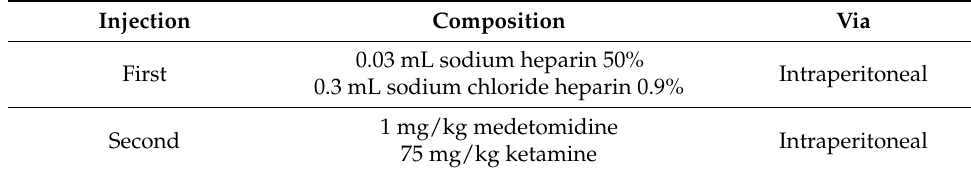
Table 1. Composition of anesthetic